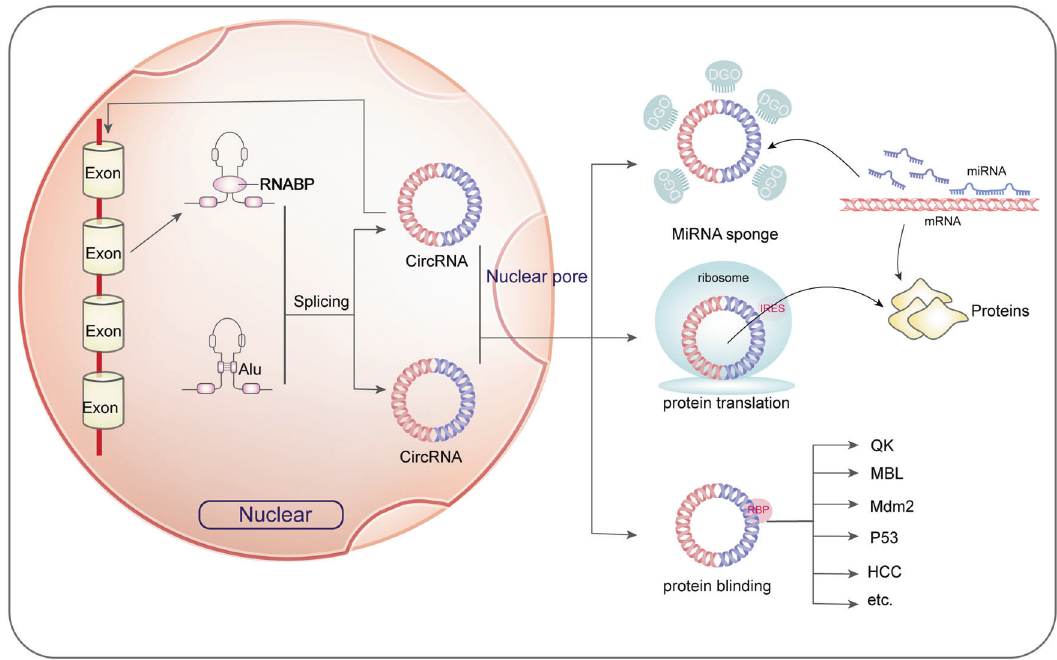
Fig. 3 Biogenesis and function of circRNA-miRNA network. circRNA is formed by pre-mrna through back-splicing. Generated circRNA usually has three functions: adsorbing miRNA as sponge, encoding and translating into short peptides, and binding functional proteins to regulate its intracellular